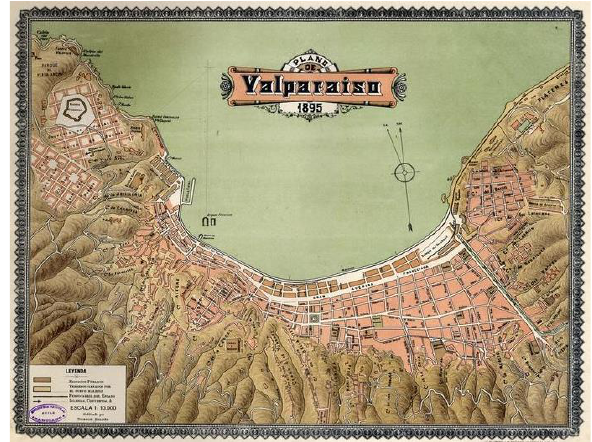
Figure 2. Valparaíso plan 1895. Nicanor Boloña: Álbum de planos de las principales ciudades y puertos de Chile.